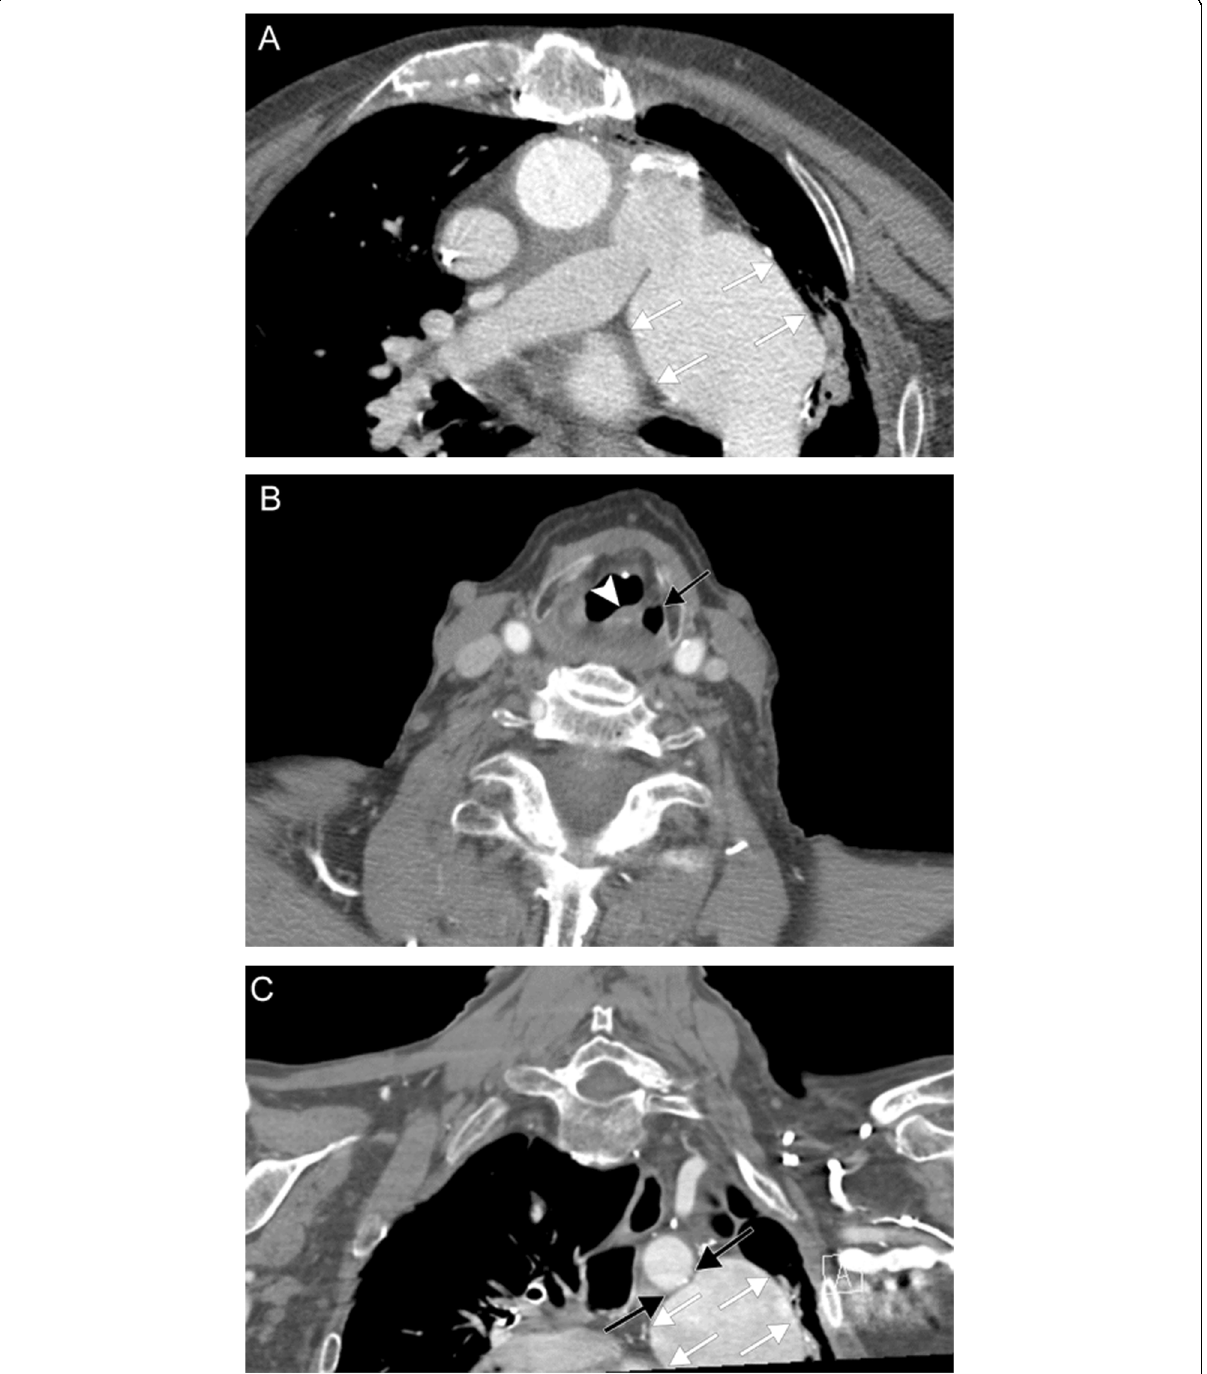
Fig. 22 Pulmonary artery aneurysm. A 78-year-old man with advanced congestive heart failure secondary to congenital pulmonary artery stenosis status post multiple corrective surgeries, now presenting with progressive shortness of breath and speaking difficulty despite adequate management of heart failure. Axial CTA image ( a ) through the mediastinum reveals aneurysmal dilatation of the left pulmonary artery (white arrows). An axial CTA image through the larynx ( b ) reveals thickening of the left aryepiglottic fold (white arrowhead) and dilatation of the left piriform sinus (black arrow). A coronal CTA image ( c ) demonstrates effacement of the aortopulmonary window (black arrows) by the pulmonary artery aneurysm (white arrows) with presumed compression of the left recurrent laryngeal